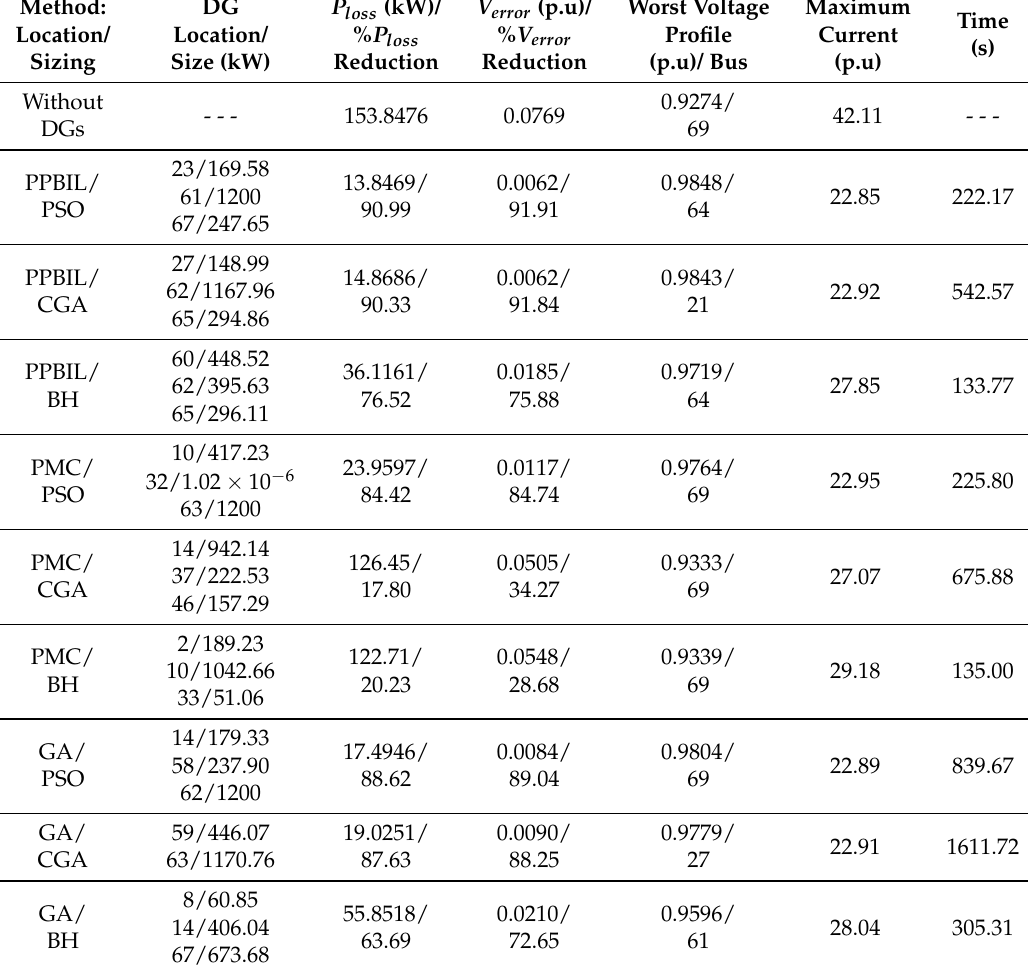
Table 7. Results of the 69 bus test